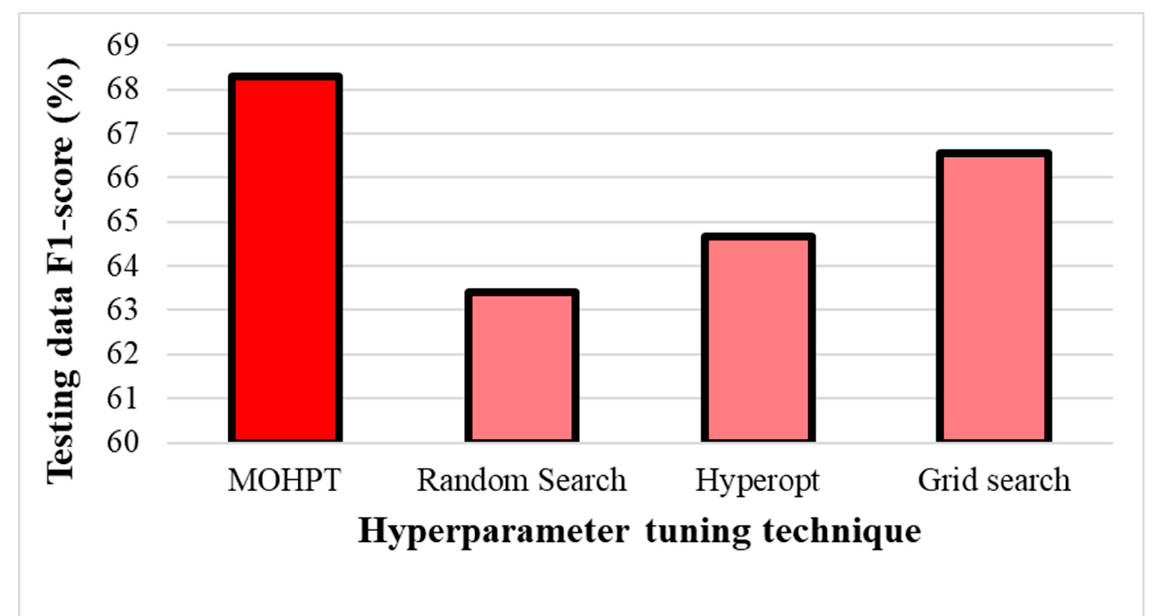
Figure 4. The testing data F1-score of hyperparameter tuning techniques.